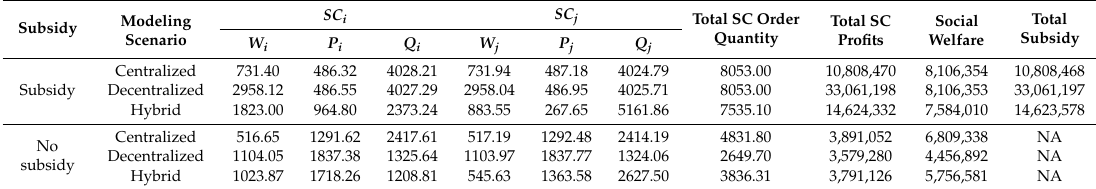
Table 4. Pricing of the supply chains under different modeling scenarios: subsidy vs. no subsidy.